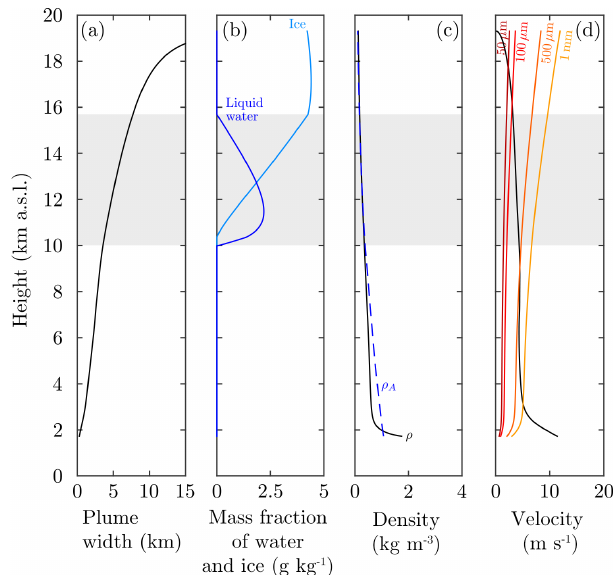
Figure 13. Model prediction of the Grímsvötn plume at 0500 on 22 May 2011, assuming 10wt% of water vapour at the source. (a) Plume width (taken as twice the Gaussian half width from the plume centreline) as a function of height. (b) Mass fraction of liquid wa- ter and ice as functions of height. (c) Density of the plume ρ p and atmosphere ρ A as functions of height. (d) Vertical velocity of the plume at the nominal plume edge (taken as twice the Gaussian half width from the plume centreline) and critical fallout velocities of 50µm, 100µm, 500µm, and 1mm particles as functions of height.